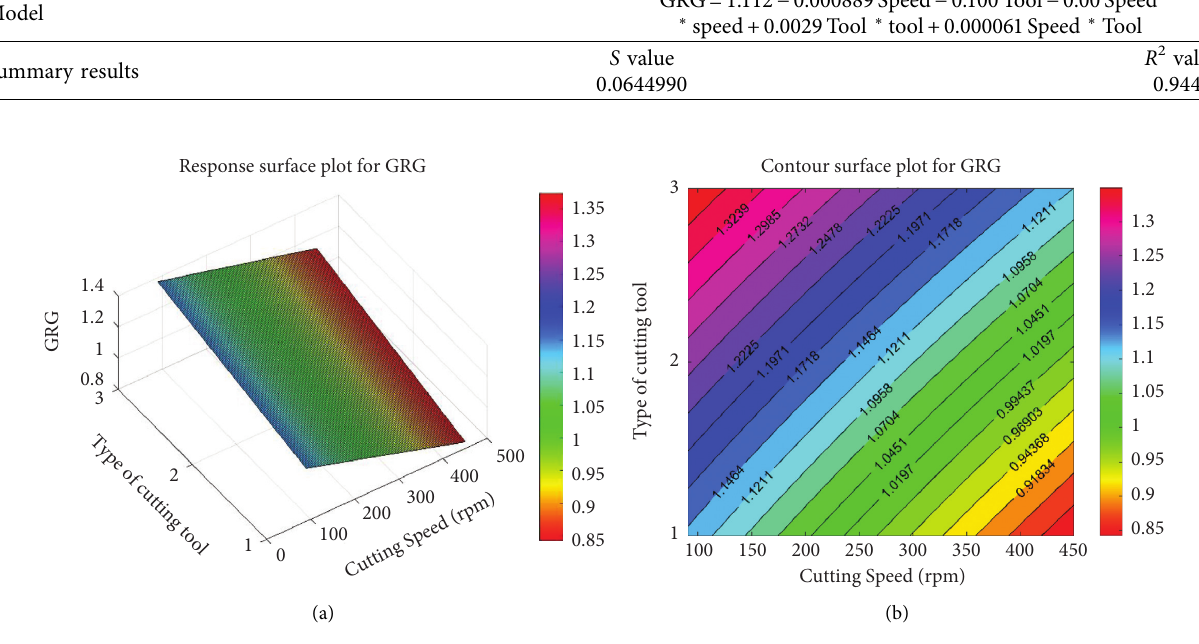
Figure 16: (a) Response surface plot for GRG (cutting speed vs. type of cutting tool). (b) Contour surface plot for GRG (cutting speed vs. type of cutting tool).